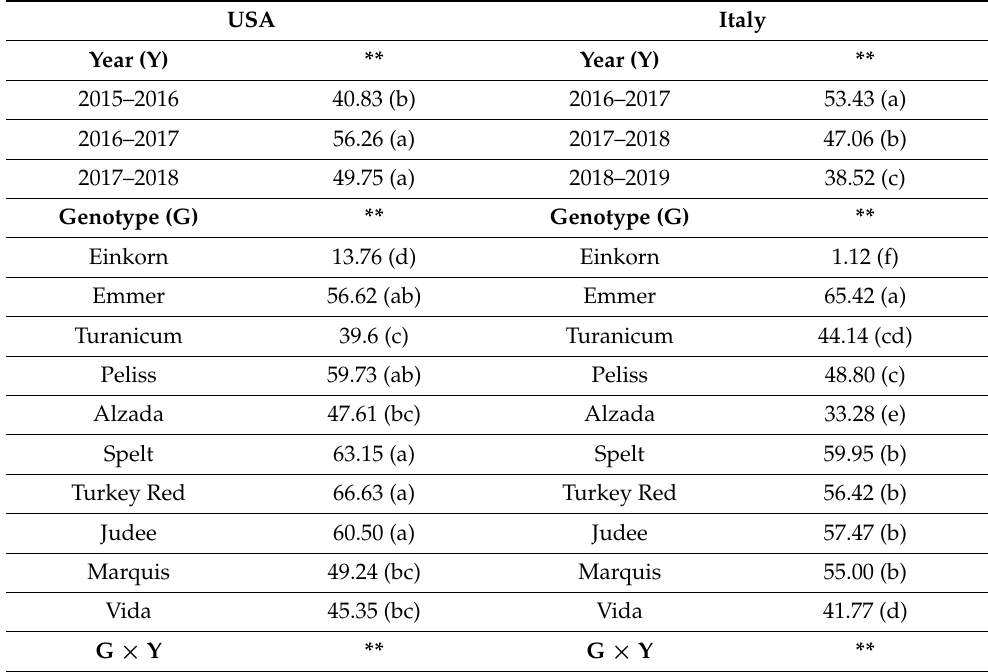
Table 2. Mean values (%) of the alpha-amylase inhibitory activity for wheat genotypes, years